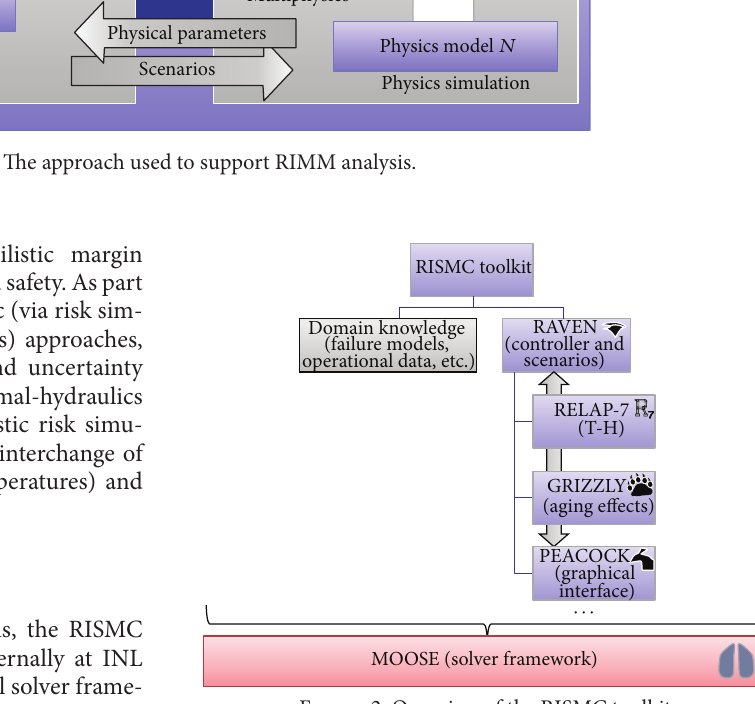
Figure 2: Overview of the RISMC